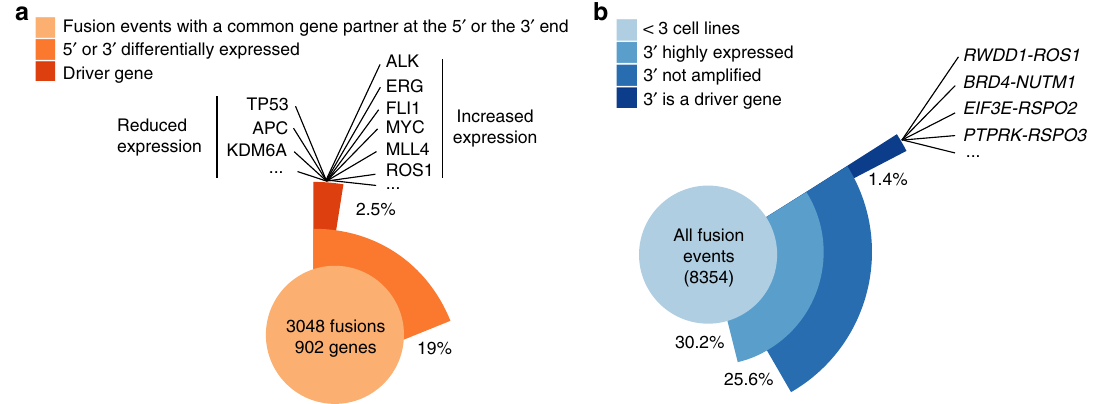
Fig. 2 Fusions impact gene expression. a Frequency of a statistical association between a recurrent fusion ( n > 2 cell lines) and differential gene expression. Examples of downregulated tumour suppressor genes (TSGs) and overexpressed oncogenes are displayed. b Frequency of co-occurrence of a gene fusion and overexpression of the 3 ′ gene for each fusion event. RSPO2 , RSPO3 , and NUTM1 are examples of overexpressed cancer driver genes involved in previously unreported gene